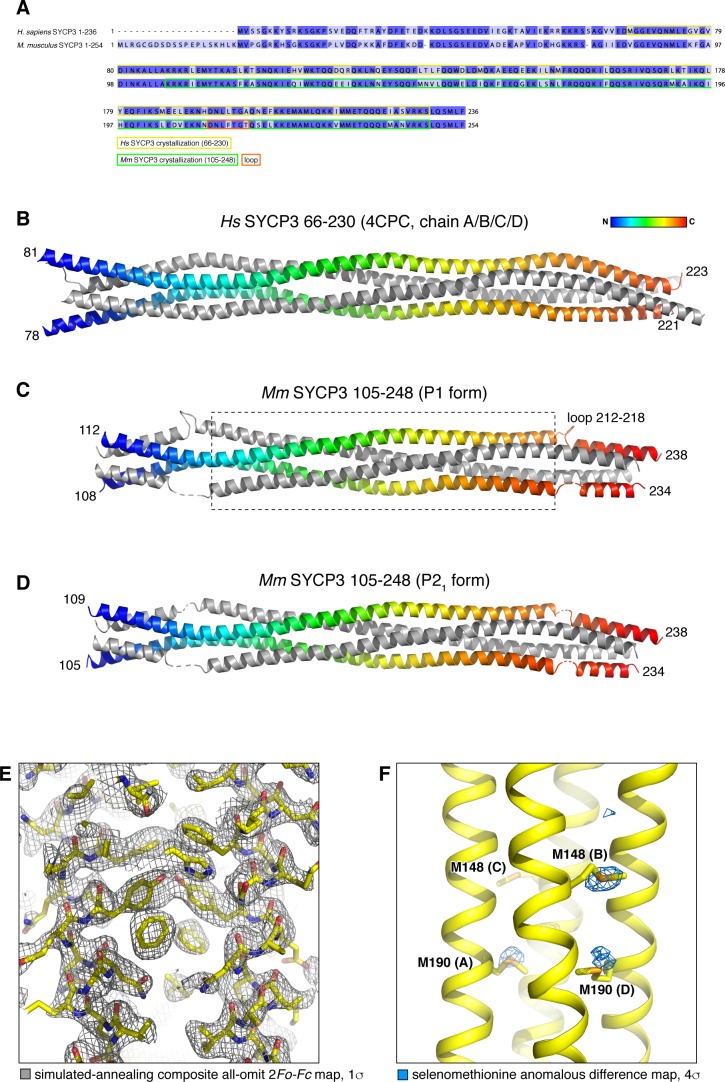
Structure of Mm SYCP3CC homotetramer and modeling of an SYCP2:SYCP3 heterotetramer.(A) Sequence alignment of H. sapiens and M. musculus SYCP3, with fragments crystallized as homotetramers highlighted. (B) Homotetramer structure of H. sapiens SYCP366-230 (PDB ID 4CPC) (Syrjänen et al., 2014). Two parallel chains are shown as rainbows, with the two antiparallel chains colored gray. (C) and (D) Homotetramer structures of Mm SYCP3105-248 (SYCP3CC) in P1 and P21 crystal forms. Both structures are shown in the same orientation as Hs SYCP3, and are colored equivalently. The structures overlay closely with Hs SYCP3 in the central region (boxed in panel (C); Cα r.m.s.d. ~1.5 Å over residues of all four chains (residues 133–210 of Mm SYCP2; 115–192 of Hs SYCP2); but differ substantially near the ends, where Ms SYCP3 residues 212–218 loop out from the coiled-coil and interact with symmetry-related complexes, thereby altering the register of the antiparallel α-helices. See Supplementary file 1 for data collection and refinement statistics of the two Mm SYCP3CC structures. (E) Closeup view of the SYCP3CC P21 crystal form, with simulated-annealing composite all-omit 2Fo-Fc map at 1.0 σ shown in gray. (F) Closeup view of the SYCP3CC P1 crystal form, with selenomethionine anomalous difference map at 4.0 σ shown in blue. The majority of methionine locations show strong anomalous difference peaks.